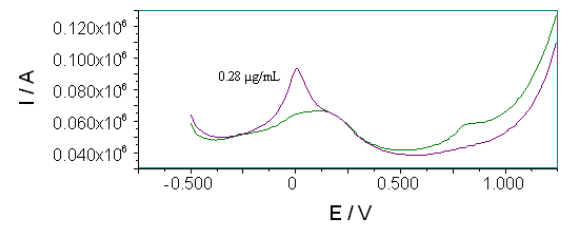
Figure 7: Differential pulse anodic stripping voltammograms obtained for determination of Cu 2+ in reaction mixture sample on glassy carbon